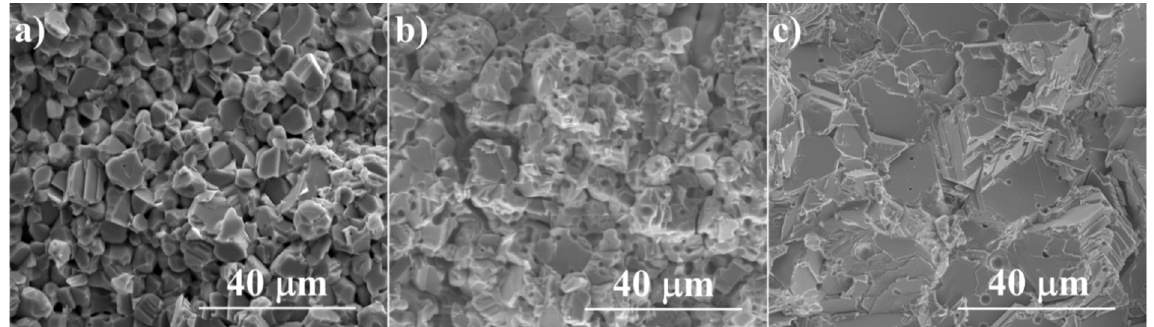
Figure 4. SEM photographs of the surface of cross-section fractures for Cu 2 Se samples sintered at ( a ) 550 °C, ( b ) 650 °C and ( c ) 720 °C.